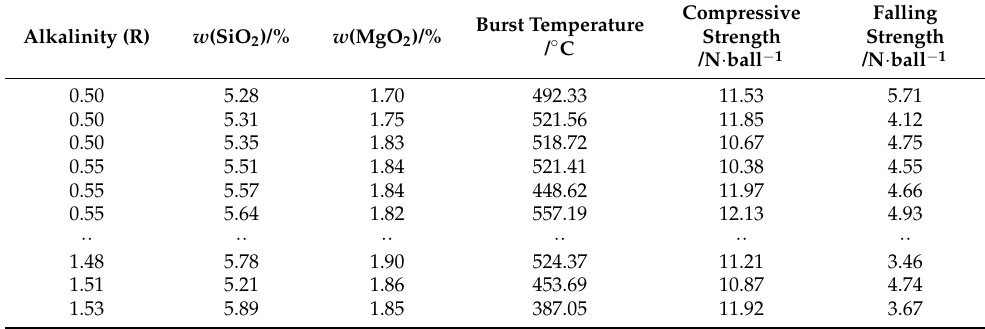
Table 8. Partially expanded